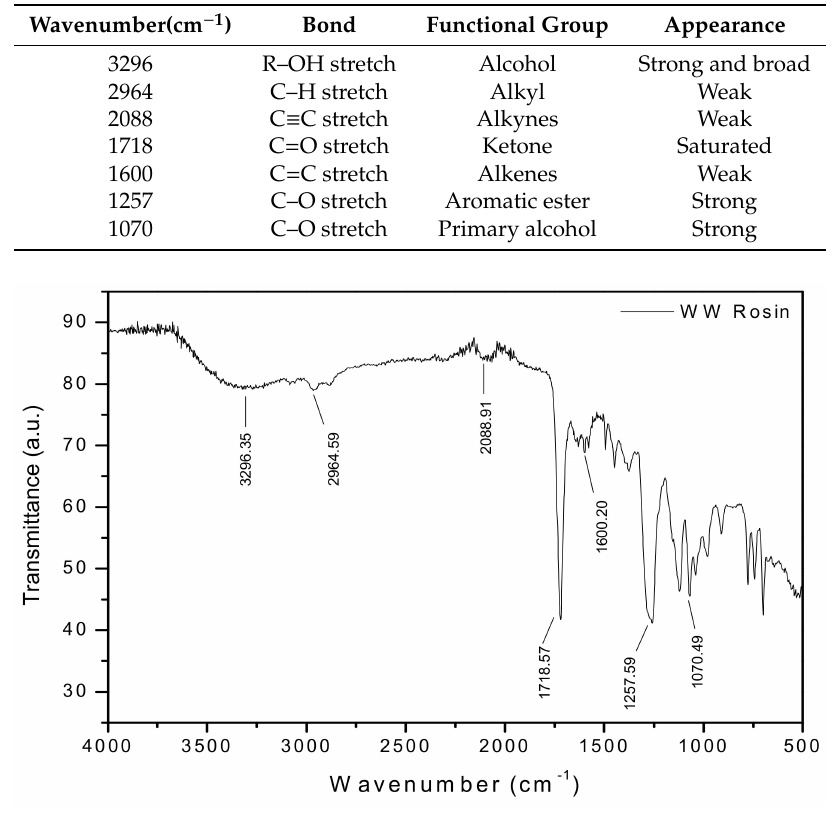
Figure 3. FTIR spectrum of WW